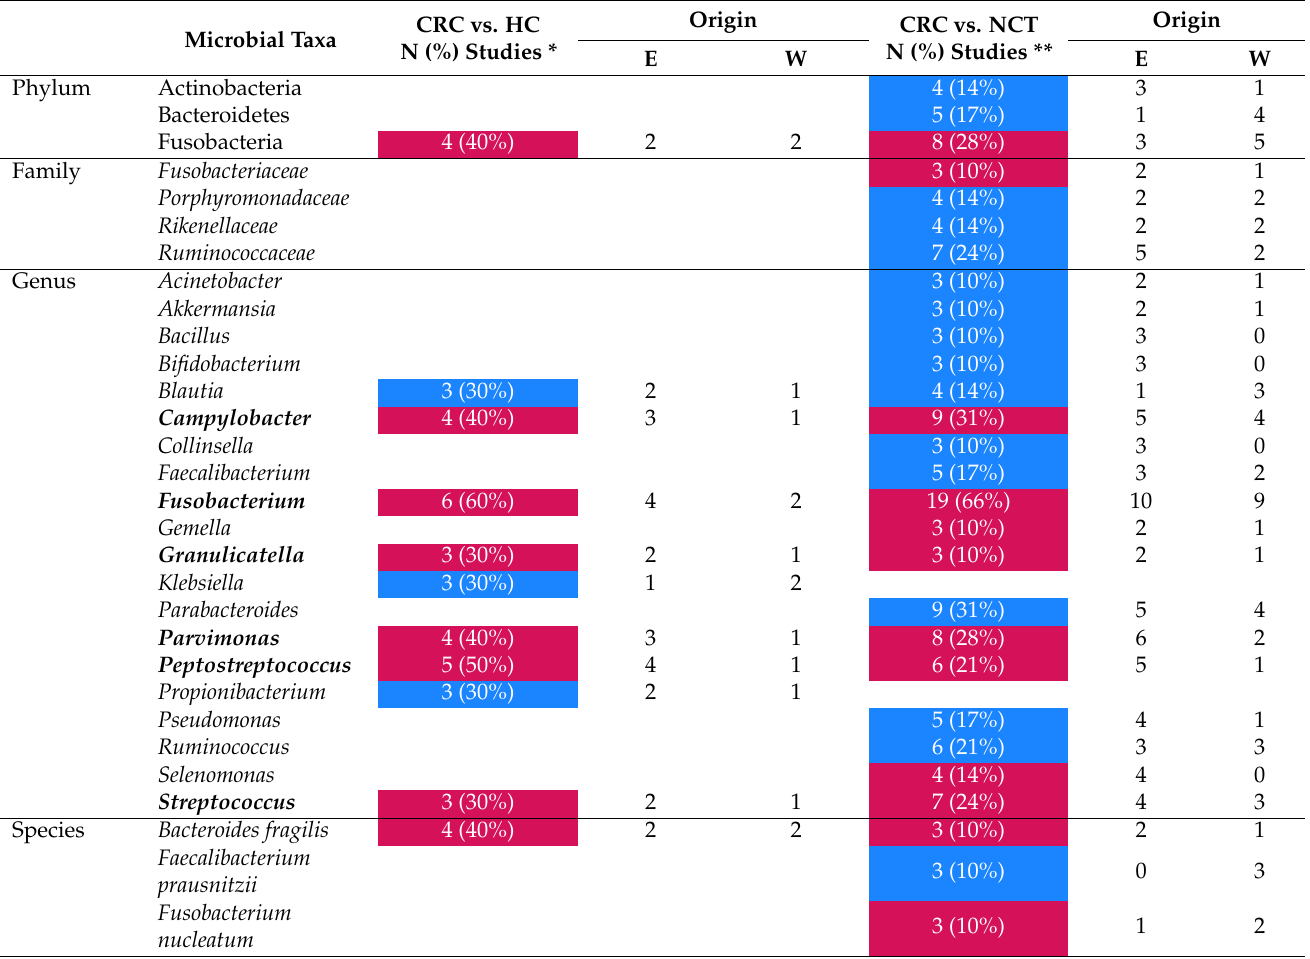
Table 5. Qualitative synthesis showing the strong microbial taxonomic associations with CRC and the geographic origin of the populations in the